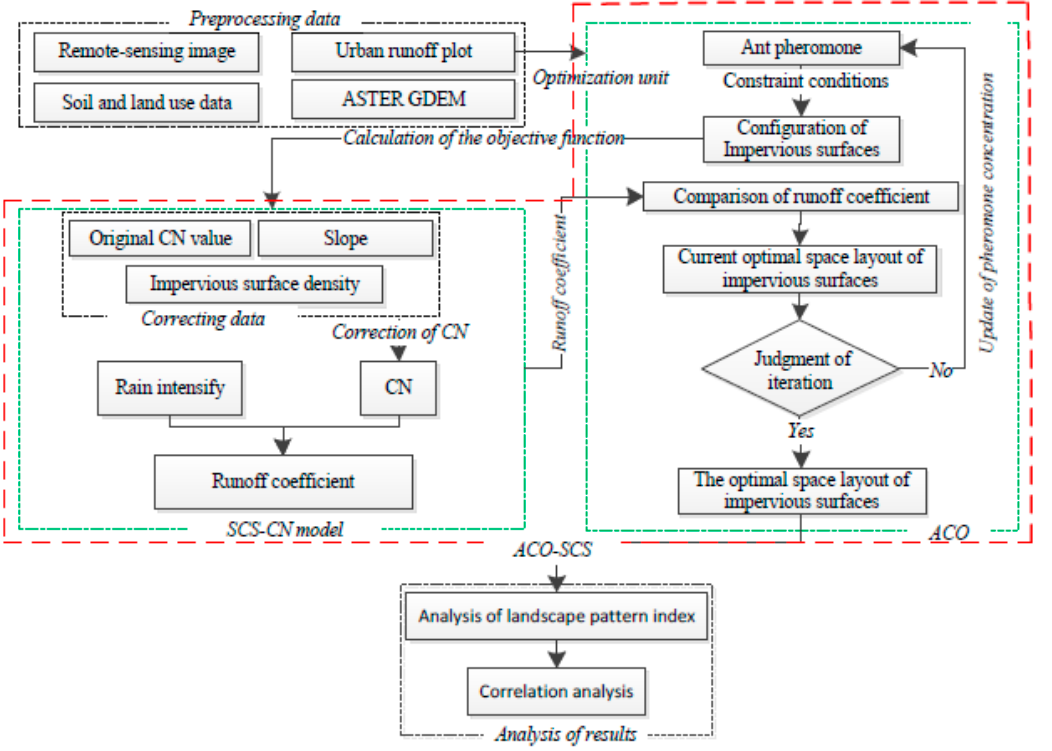
Figure 1. Integrated framework. Abbreviations: SCS-CN, Soil Conservation Service curve number; ACO, ant colony optimization; ASTER GDEM, Advanced Spaceborne Thermal Emission and Reflection Radiometer Global Digital Elevation Model.